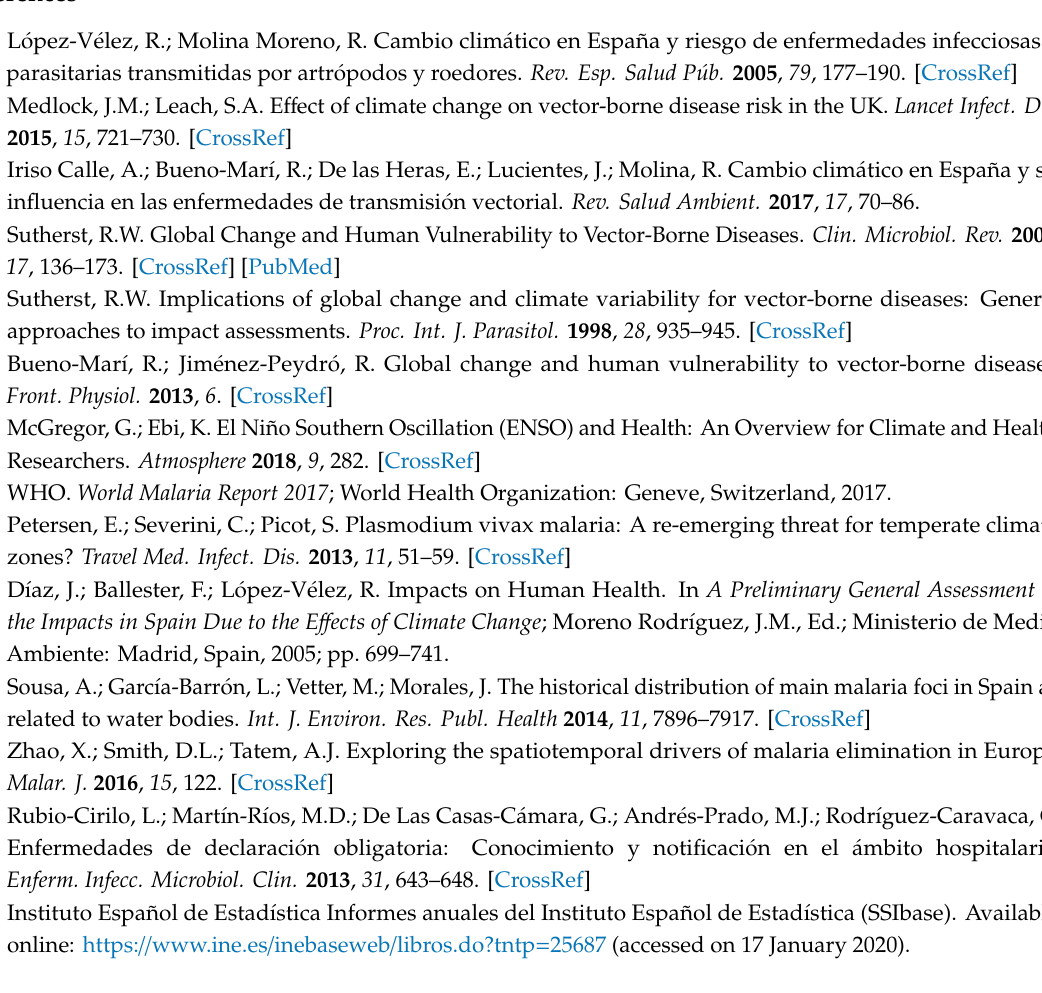
Figure A2. Map of the provinces of Spain.